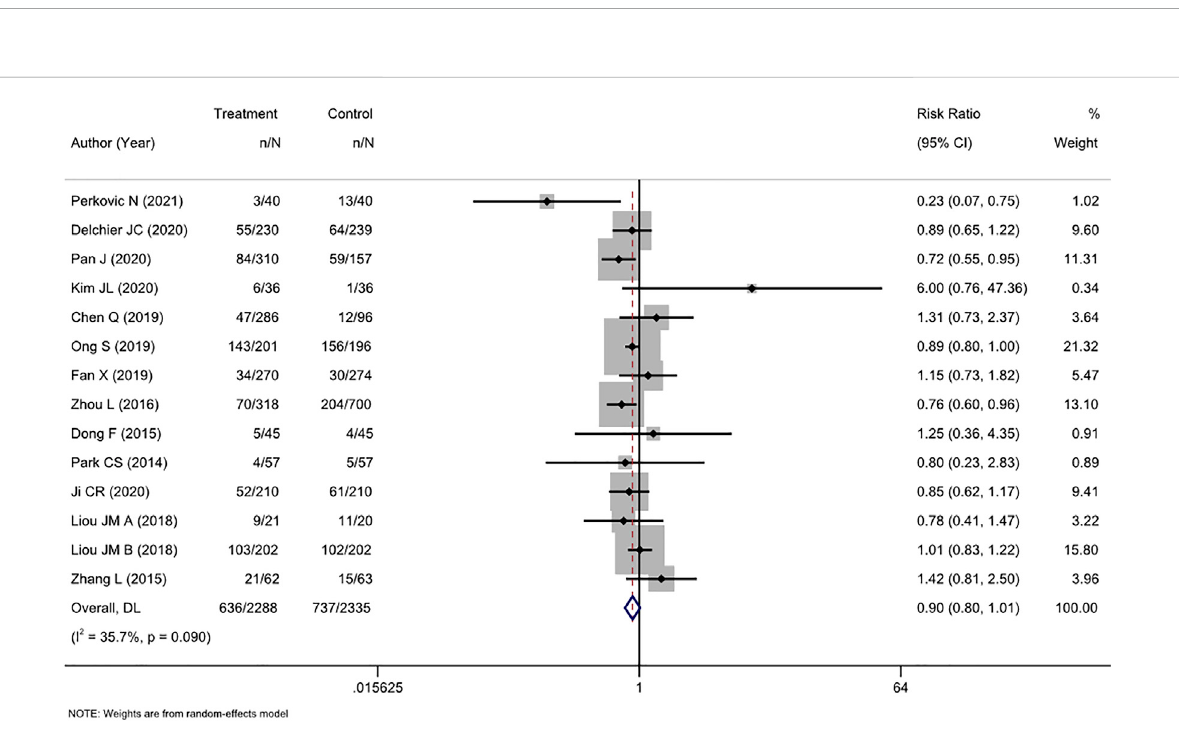
FIGURE 5 Forest plot of the adverse events of RCTs comparing tailored treatment with empirical